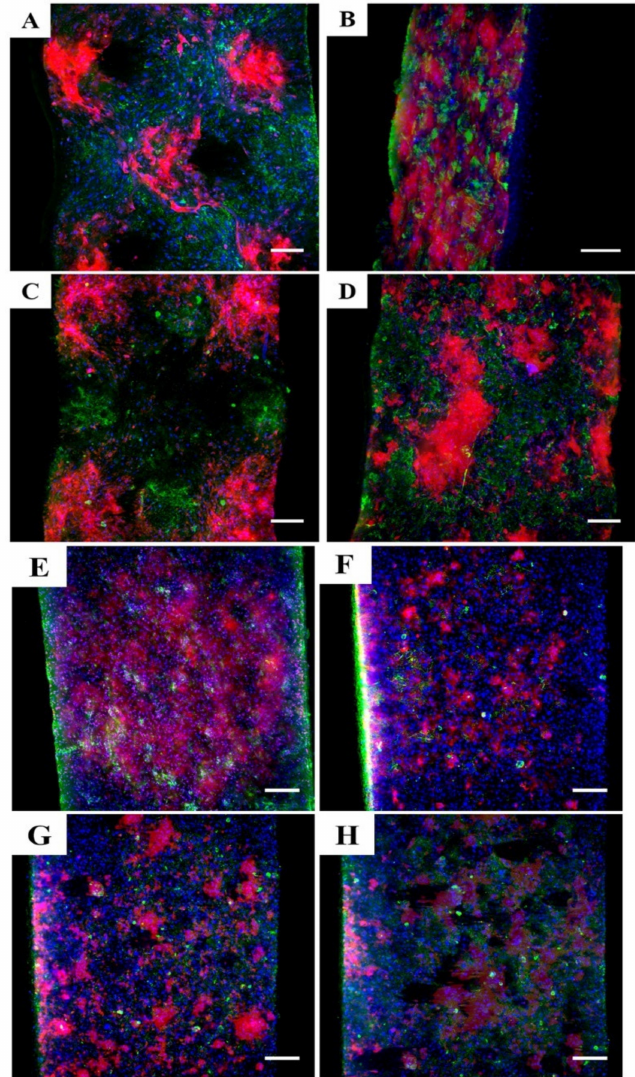
Figure 7. Lightsheet microscopy images of TCES seeded with HDF + HDK and fabricated with ( A ) PCL control, ( B ) 8% 2dDr, ( C ) 10% E2, and ( D ) 10% AV. RES seeded with HDF + HDK and fabricated with ( E ) PCL control, ( F ) 8% 2dDr, ( G ) 10% E2, and ( H ) 10% AV are also shown. Samples were immunostained for I β 1 (red), COL IV (green), and DAPI (blue). Scale bar = 200 µ